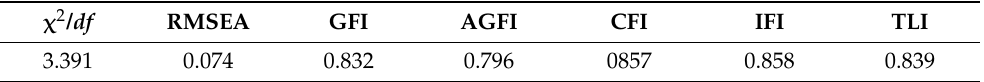
Table 9. Table of Optimal Measurement Model Overall Fitting Coefficient.